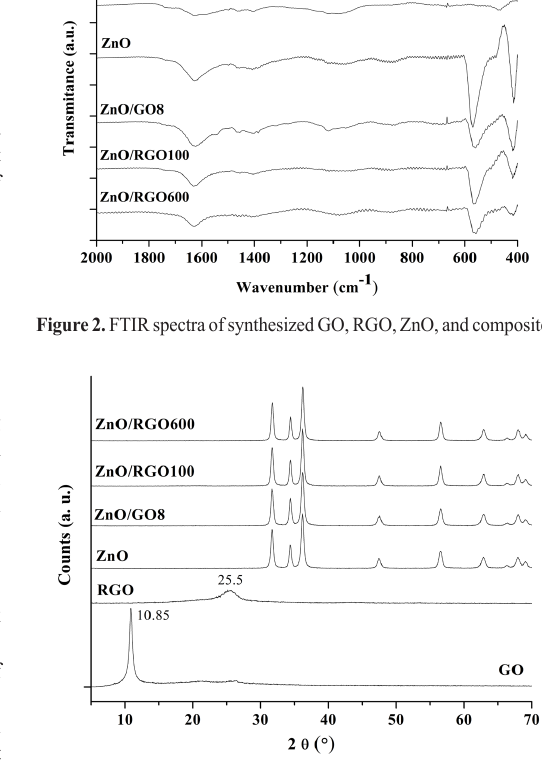
Figure 3. XR diffraction patterns of synthesized GO, RGO, ZnO, and